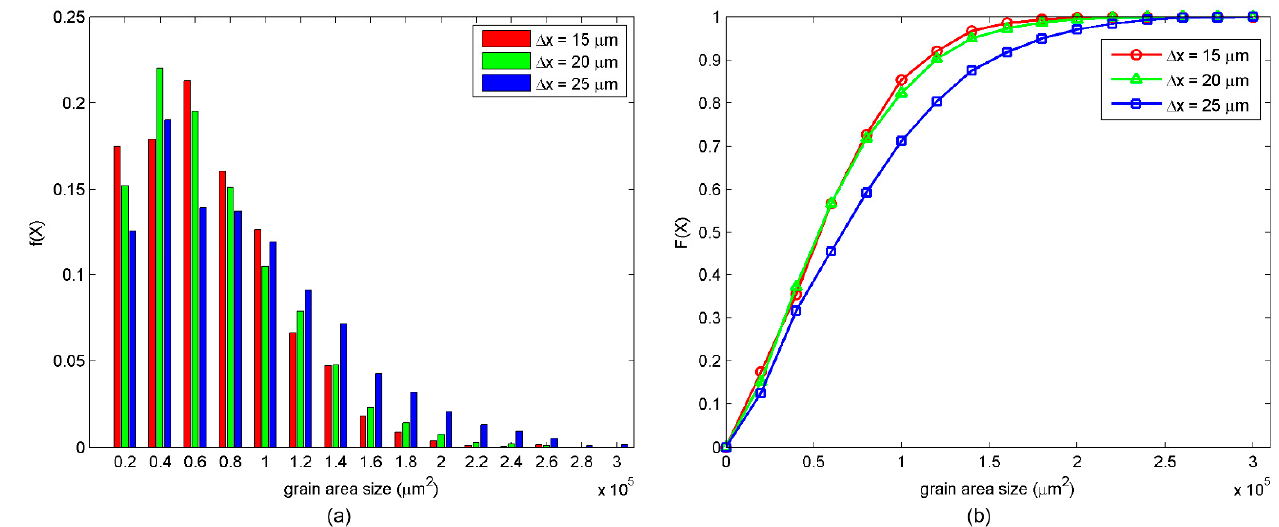
Figure 7. Grain area size distribution ( a ) and the cumulative grain area size distribution ( b ) with different cell size.